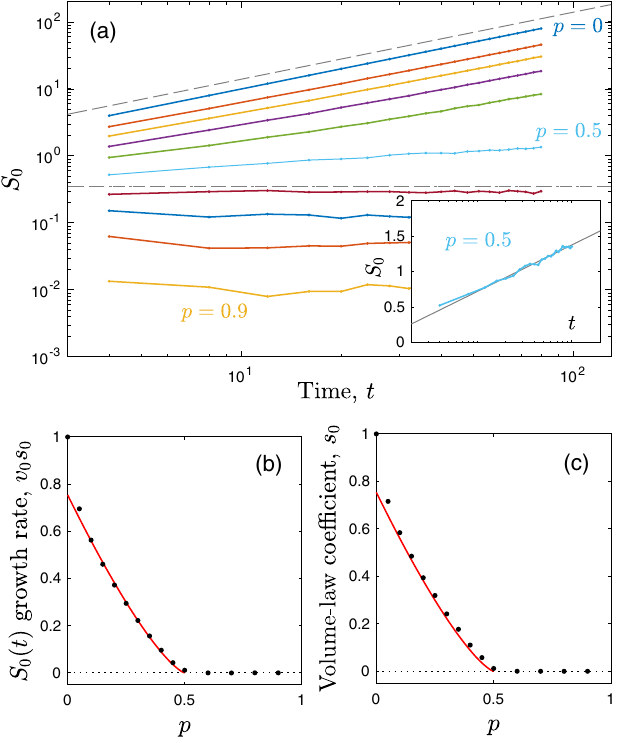
FIG. 9. Growth of the minimal-cut cost S 0 separating two halves of the classical percolation network, as measured by numerical simulations. (a) Dependence of S 0 on time t for a network with aspect ratio L ¼ 4 t (note the double logarithmic scale). Different curves correspond to different values of p , ranging from p ¼ 0 (topmost curve) to p ¼ 0 . 9 (bottom curve) in steps of 0.1. The dashed lines show, respectively, the dependence S 0 ∝ t and S 0 ¼ const. The inset shows S 0 at p ¼ 0 . 5 on a semilogarithmic scale, and the thin solid line shows a fit to the form S 0 ¼ A ln t þ B , which gives A ¼ 0 . 27 (cid:4) 0 . 01 and B ¼ 0 . 063 . (b) The rate of entanglement growth v 0 s 0 as a function of p , extracted by measuring the linear slope of the 4 = 3 , as data in panel (a). The red line shows v 0 s 0 ∝ ð p − p c Þ suggested by Eq. (10). (c) The coefficient of the volume-law entanglement, s 0 , as a function of p , which is extracted by measuring the linear slope of the dependence S 0 ð L Þ ∝ s 0 L for networks with t ¼ 4 L . The red line is identical to the one in (b). All data in this figure are averaged over 4000 realizations of the random